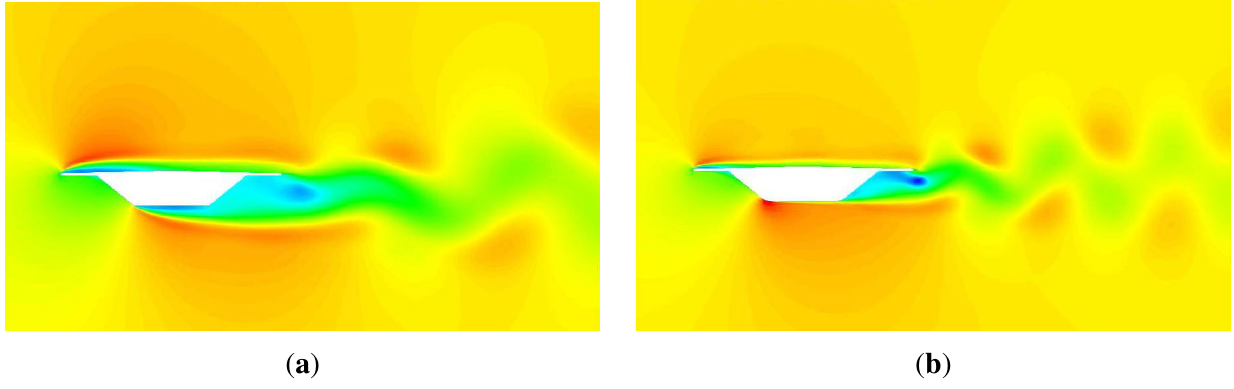
Figure 21. Streamwise velocity flow field for the bridge section with sharp ( a ) ( R/B = 0) and with rounded lower edges ( b ) ( R/B = 0.05). The angle of attack is null, and the = 34 m/s. The indicated flow velocities range between − 20 undisturbed flow speed is U ∞ and 50 m/s.